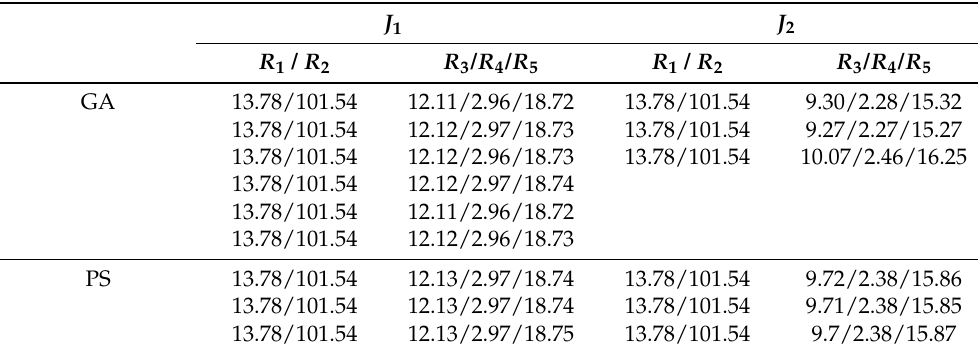
Table 4. Computed values for components of controller’s partial fraction expansion (20) and corre- sponding electrical circuit of Figure 6, where C 1 = C 2 = 2.2 µ F and R = 1 k Ω . Units for R 1 and R 2 are given in Ω . Units for R 3 , R 4 and R 5 are given in k Ω .